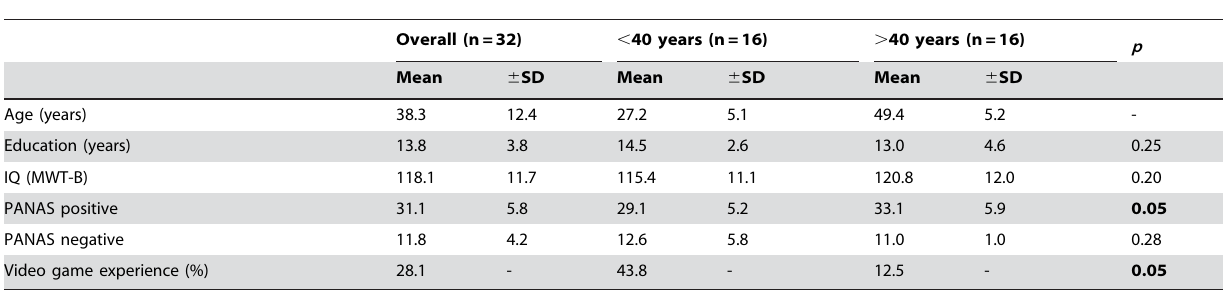
Table 3. Demographic information on the experimental groups.